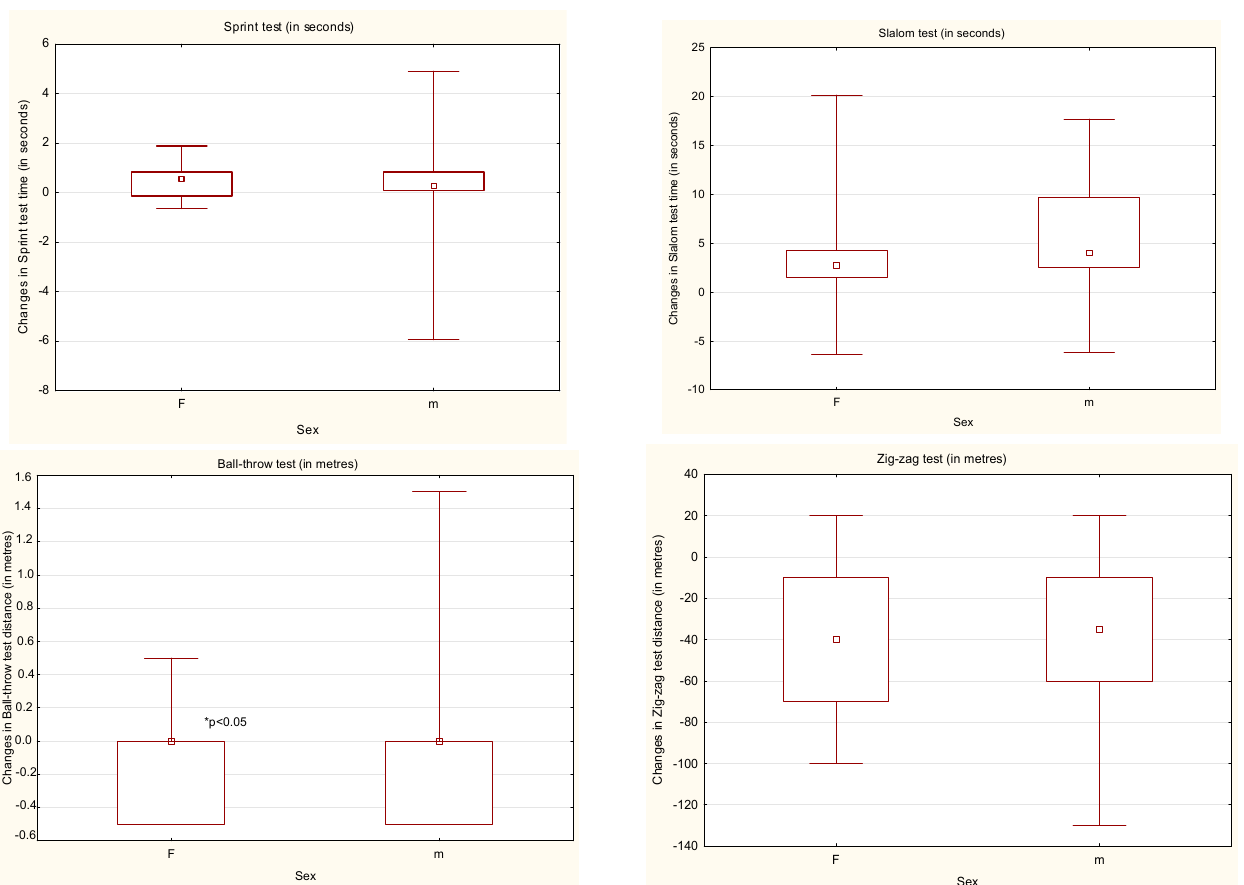
Figure 1. The changes in the results obtained before and after the ARC by the participants according to sex. F—female; m—male. Table 2. The results obtained in the sprint test by the study participants before and after ARC. Sprint Test (Time in